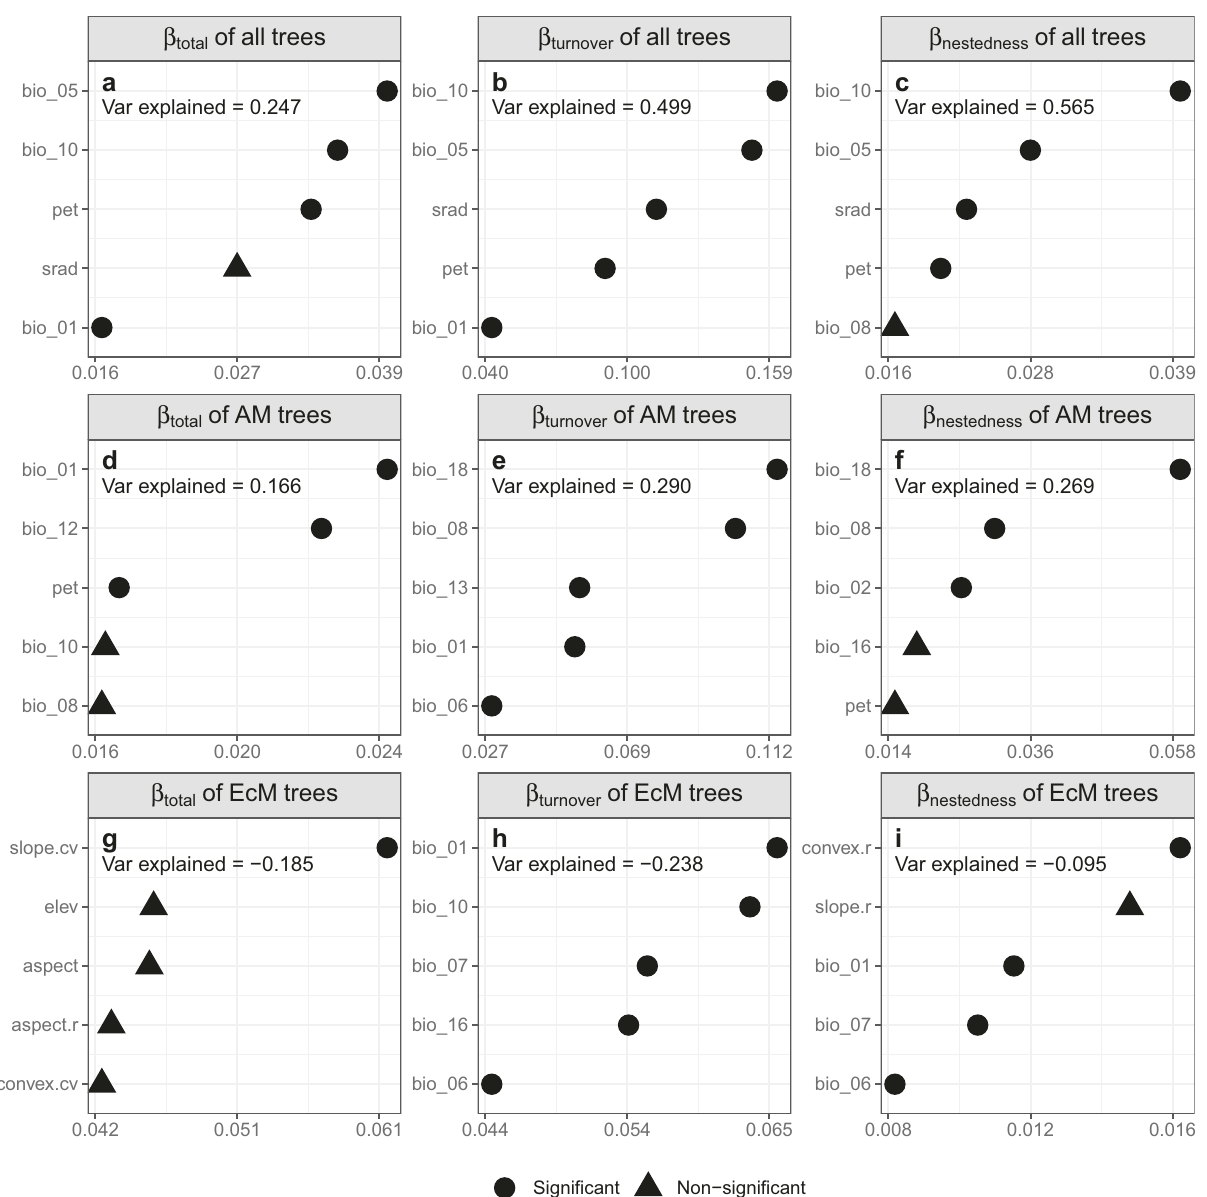
Fig. 4 Speci fi c effects of environmental variables on latitudinal gradients in tree beta-diversity. Relative importance of fi ve most important environmental factors for total beta-diversity, species turnover, and species nestedness of all trees ( a – c ), AM trees ( d – f ), and EcM trees ( g – i ) at the scale of 20 m × 20 m. Total beta-diversity and its components are the mean values of 200 replicates of average pairwise beta-diversity and its component metrics calculated based on 15 randomly sampled quadrats of 20 m × 20 m from each forest plot. The relative importance of variables was ranked by the increase in node purity (horizontal axis). The proportion of variance displayed was explained by all of 34 environmental variables. Circle points indicate signi fi cant importance of predictors whereas triangles indicate non-signi fi cant importance of predictors. The meanings of environmental variables are as follows: bio_01 = Annual Mean Temperature, bio_02 = Mean Diurnal Range (Mean of monthly (max temp - min temp)), bio_05 = Max Temperature of Warmest Month, bio_06 = Min Temperature of Coldest Month, bio_07 = Temperature Annual Range (BIO5-BIO6), bio_08 = Mean Temperature of Wettest Quarter, bio_10 = Mean Temperature of Warmest Quarter, bio_12 = Annual Precipitation, bio_13 = Precipitation of Wettest Month, bio_16 = Precipitation of Wettest Quarter, bio_18 = Precipitation of Warmest Quarter, srad = Solar Radiation, pet = Potential Evapotranspiration, elev = Elevation, aspect = Slope Aspect, aspect.r = Range of Aspect, convex.r = Range of Curvature, slope.cv = Coef fi cient of Variation of Slope, convex.cv = Coef fi cient of Variation of